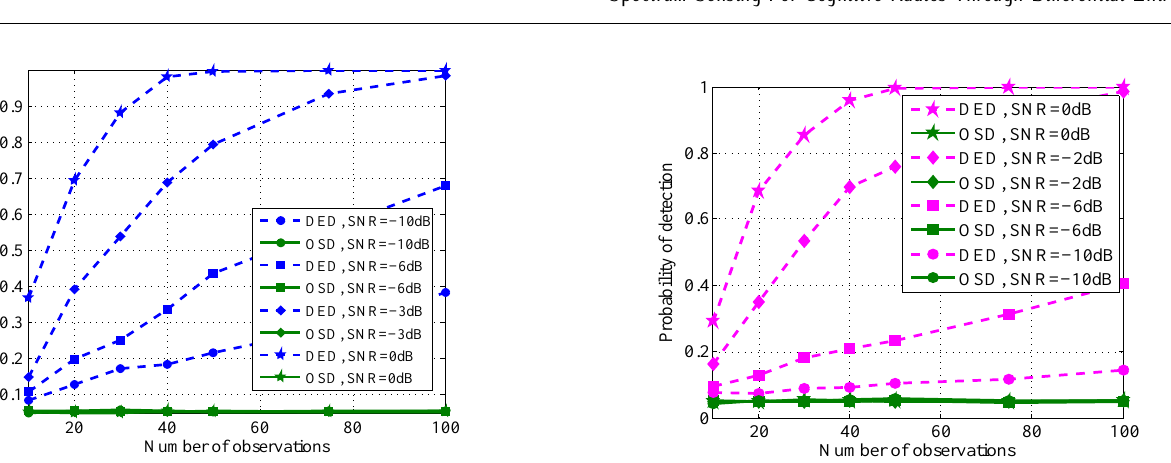
Figure 6. Probability of detection: DED and OSD vs. M for different primary SNRs | Rayleigh fading | Laplacian noise | Gaussian primary signal.